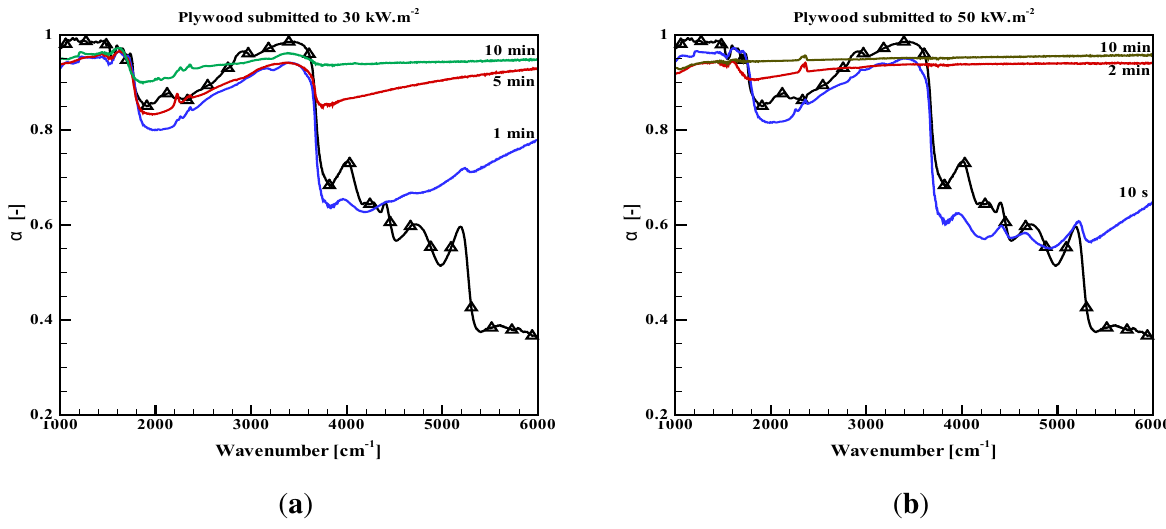
Figure 4. Absorptivity of a plywood sample submitted to thermal degradation during